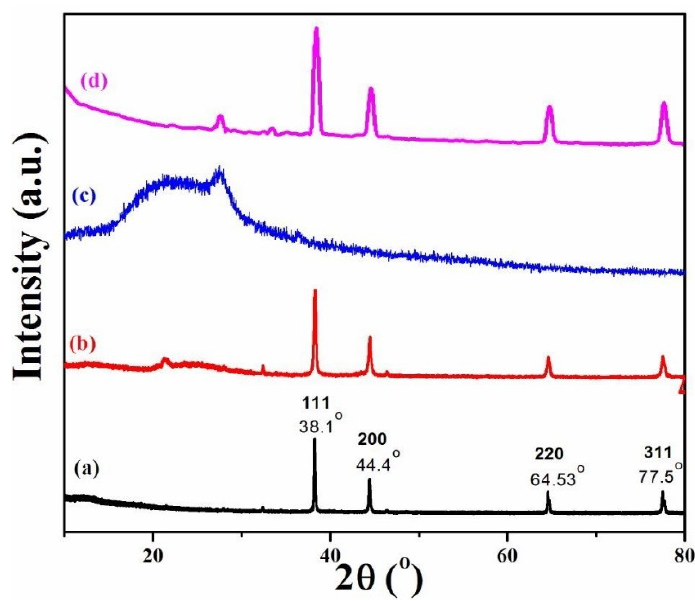
Figure 2. XRD patterns of ( a ) AgNPs, ( b ) RGO/AgNPs, ( c ) RGO/AgNPs-(PS-PMMA), and ( d ) R-(GO-(PS-PMMA)-AgNPs.